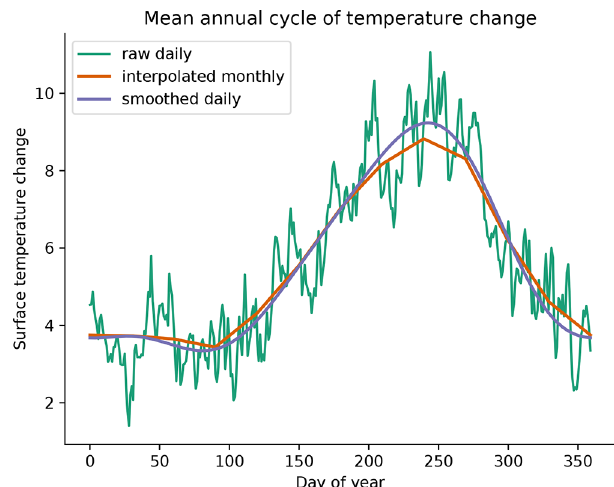
Figure 3. Mean annual cycle of the PGW climate change signal at a specific grid point in Europe for different methods of construct- ing the annual cycle from GCM data. The green line shows the raw signal from two 30-year periods at daily resolution. It is strongly influenced by daily and interannual variability. The orange and blue lines show different methods of constructing a smooth and contin- uous annual cycle. The orange line shows the result of linear inter- polation between monthly mean values. The blue line is the result of smoothing the daily values using spectral filtering. Both filtering methods are supported by